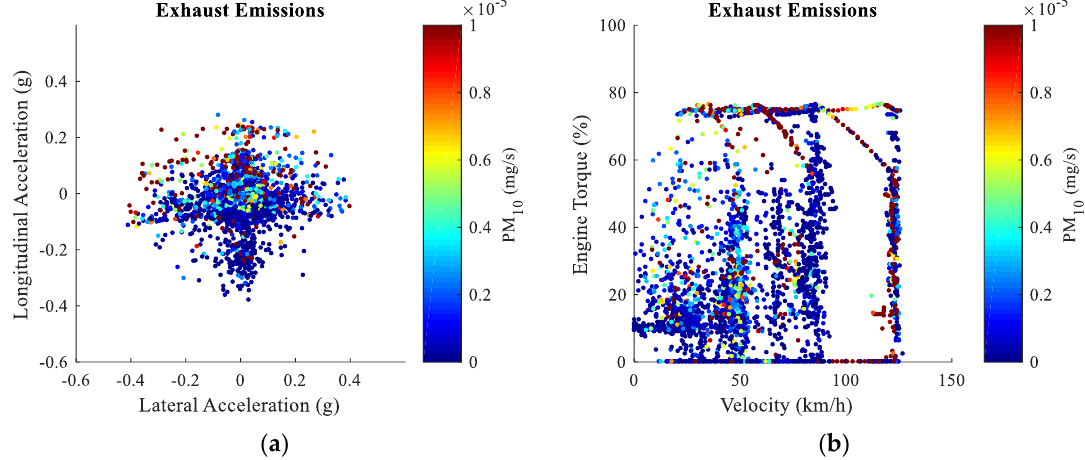
Figure 4. Correlation between vehicle dynamics and particle generation: exhaust emissions as a function of ( a ) vehicle acceleration, ( b ) engine torque and velocity. Friction brakes are based on the conversion of kinetic energy into thermal